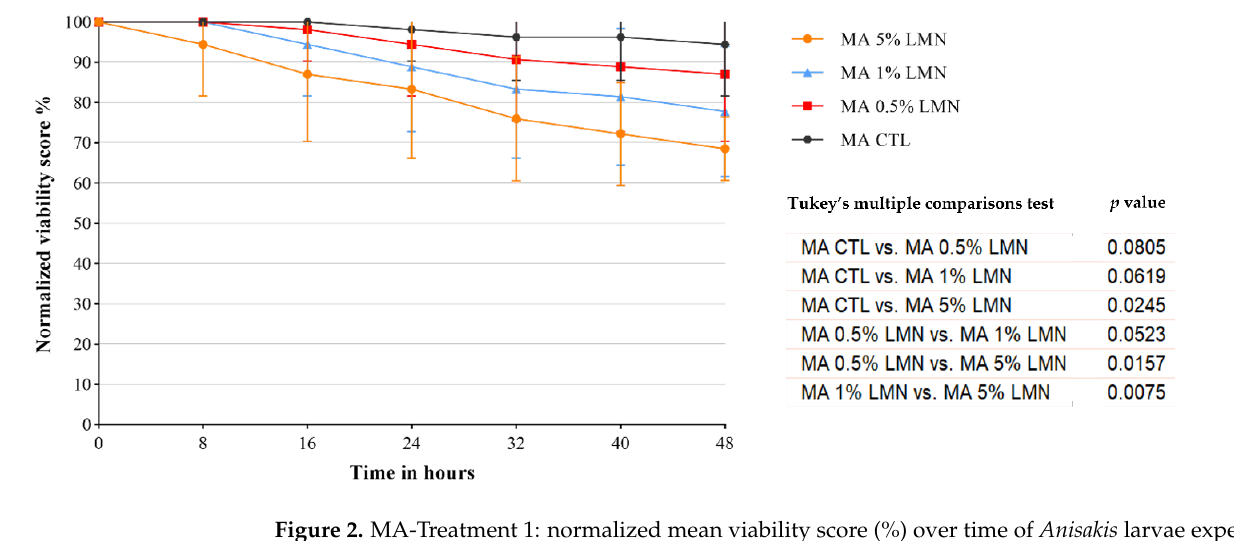
Figure 2. MA-Treatment 1: normalized mean viability score (%) over time of Anisakis larvae experi- mentally parasitized in anchovy fillets treated with different R (+) limonene (LMN) concentrations (5%, 1%, 0.5%) in a typical industrial marinating solution and relative control (CTL) without LMN. The results of the statistical analysis performed for the different treatments are also reported.